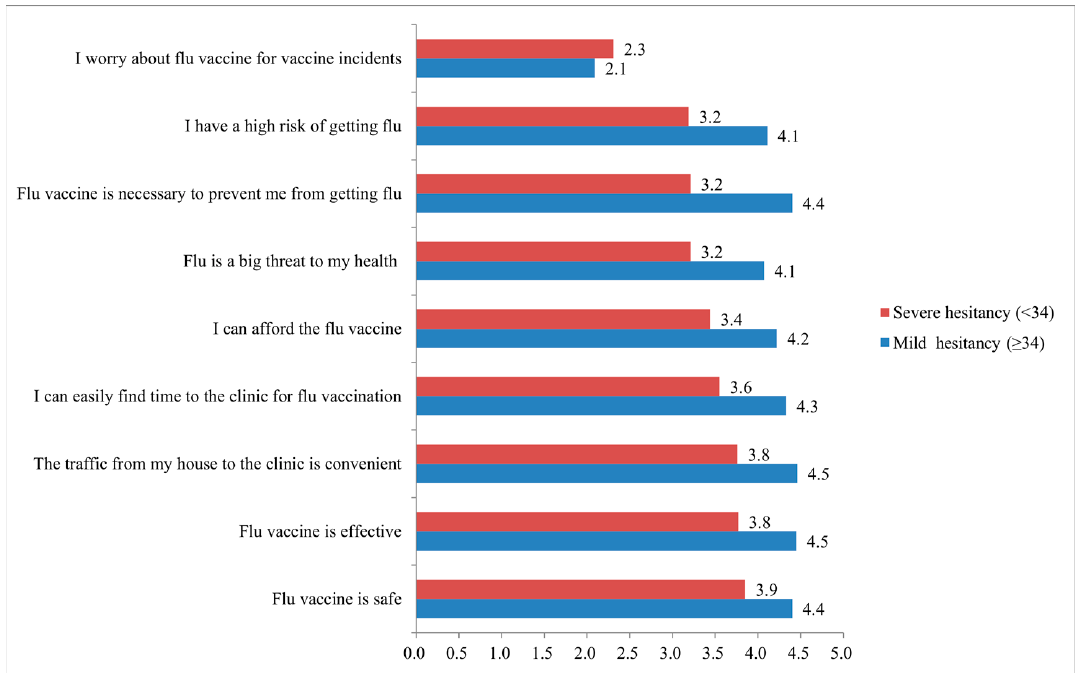
Figure 2. Subgroups and characteristics of influenza vaccine hesitancy (IVH): difference in each item between mild and severe hesitancy was significant ( p < 0.001) by independent sample t -test.